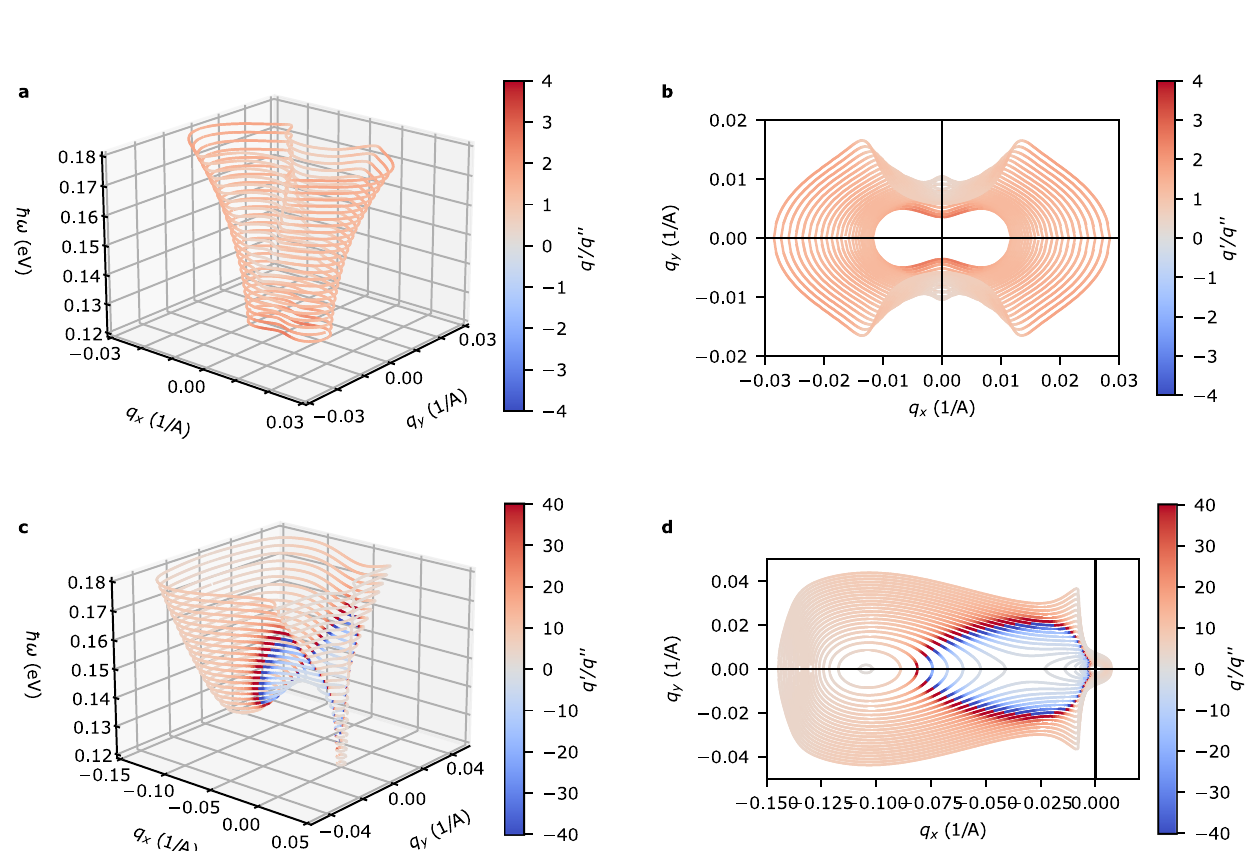
Fig.3|Thresholddriftvelocityforgain.a Thegainmetric g ( α , u )isshownasa2D color plot. A clear linear boundary between regions with and without plasmonic gain is observed. The red dashed line is a linear fi tting to the transition boundary that gives α =50.99 u / v − 6.508. b A slice of the 2D color plot at α =8eVÅ 2 (white dashed line in Fig. 3a) is shown. The inset band structures schematically show the